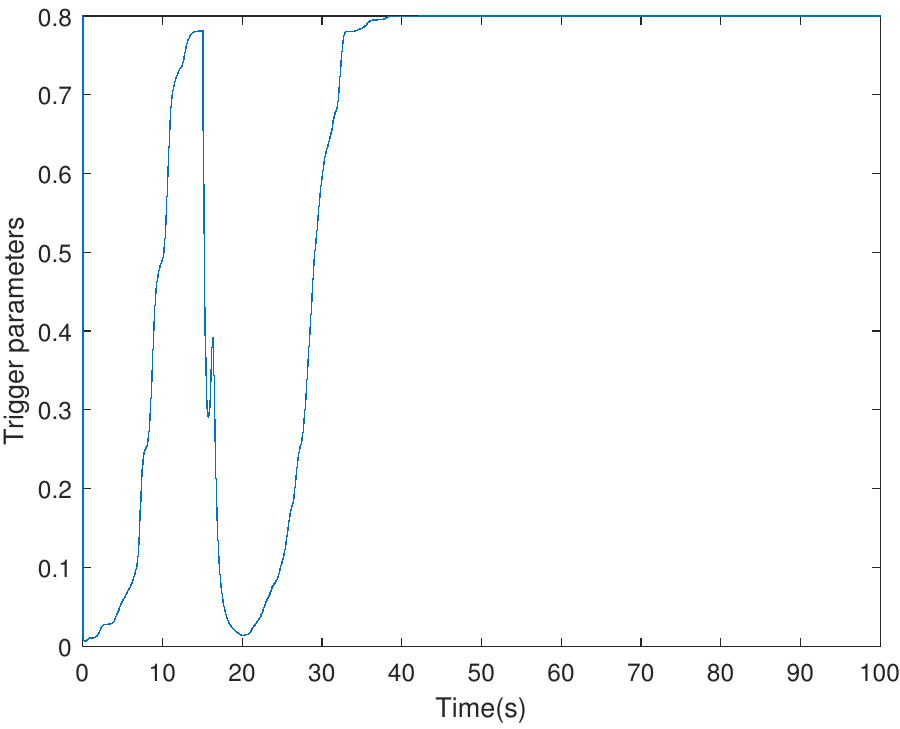
Figure 8. The threshold σ ( t ) of the system with the adaptive ETS in Case 2.